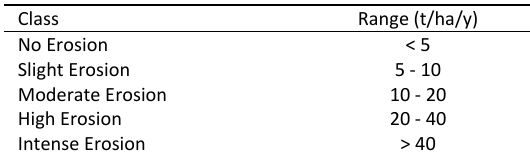
Table 3: Soil erosion rate classification limit (based on national bureau of soil survey and land use planning)